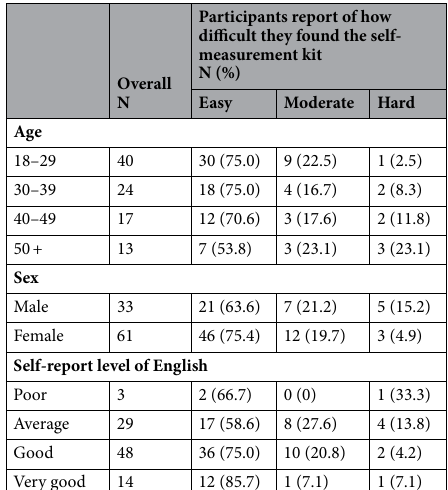
Table 1. Distribution of the study population by key characteristics, and the number and percentage within each group of these characteristics who reported that the self-measurement kit was easy/moderate/hard to use.